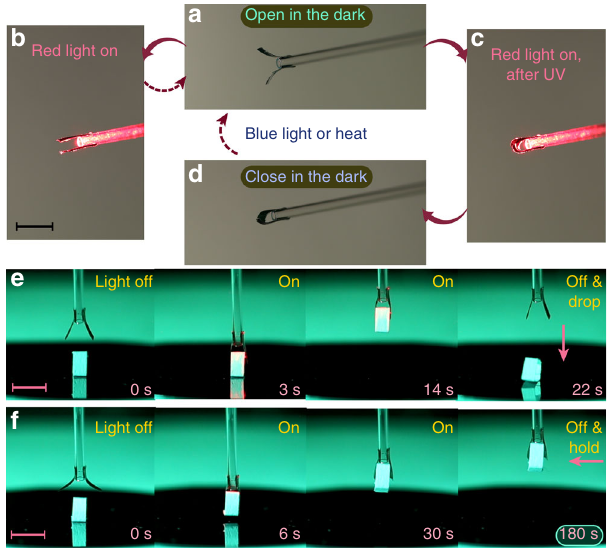
Fig. 5 A recon fi gurable micro-gripper. A gripper in its initial, open stage ( a ) closes upon red-light illumination ( b ) and returns back to the original state when turning off the light. After UV exposure, the gripper closes upon red- light illumination ( c ) and maintains the closed state even after ceasing the irradiation ( d ). e Series of optical images of the gripper operated in a grip- and-release mode, and f the same device reprogrammed to operate in a grip-and-hold mode. Object being lifted up in ( e , f ) is 12 mg in weight.